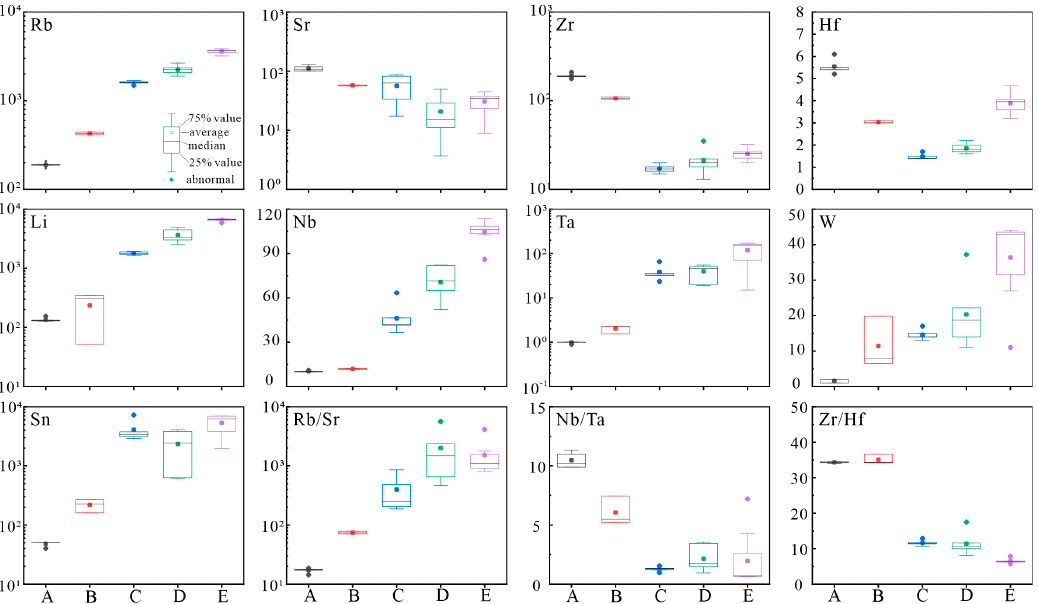
Figure 9. Statistical map of the trace element contents of different types of rocks in the Ganfang composite pluton. (Legend description: A denotes biotite granite, and the data are from unpublished data of our project team; B denotes protolothionite muscovite granite, and the data are derived from [8]; C denotes muscovite granite; D denotes lepidolite granite, and the data are from [7,8]; E denotes aplite, and the data are from unpublished data of the project team and [7] ) .